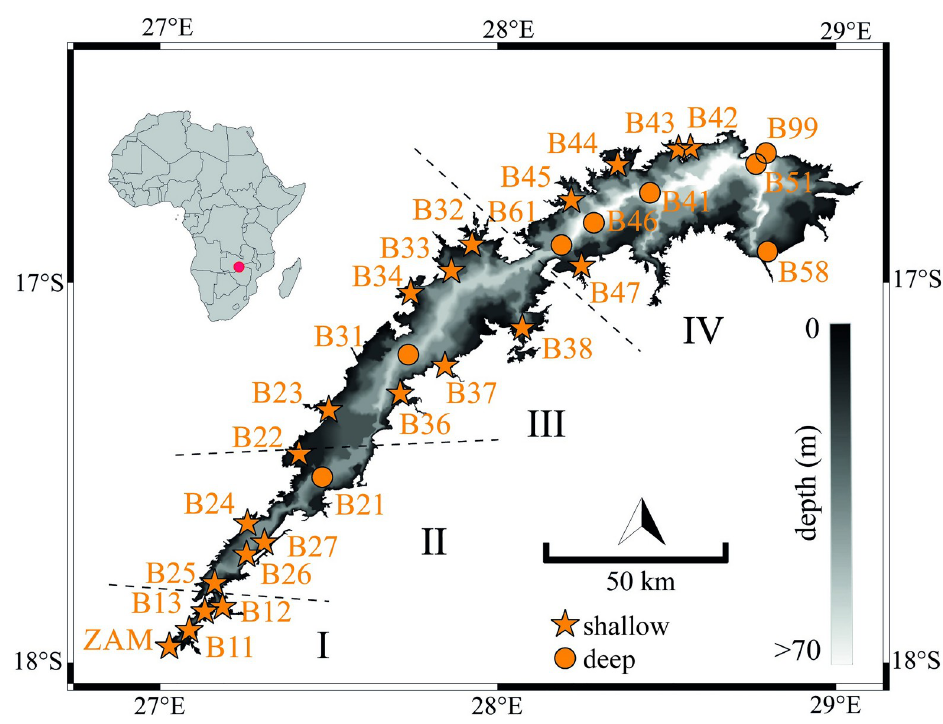
Fig 1. Geographical location in the Zambezi River Basin (Southern Africa) and bathymetric map of Lake Kariba. Orange markers indicate locations of in situ vertical profiles of temperature and dissolved oxygen at sites deeper (circles) or shallower (stars) than 50 m. Dashed lines separate the four sub-basins of Lake Kariba, and the naming of the sites corresponds to the open data collection of this study [34].